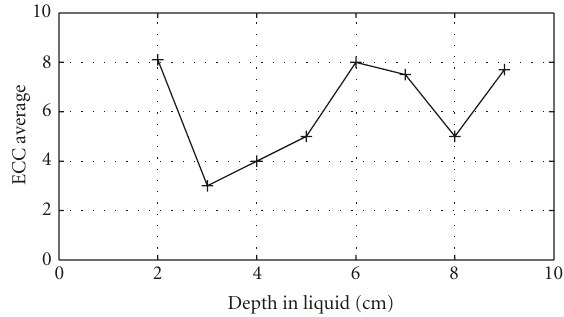
Figure 6: ECC invocation versus Depth in liquid.